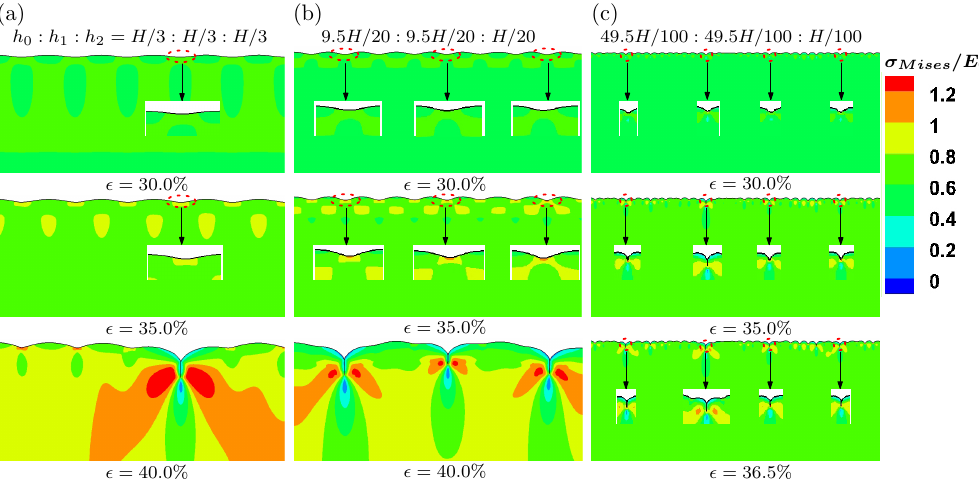
Figure 9. Evolution of surface morphology for a three-layer model at three different levels of compressive strain. ( a ) case I h 0 : h 1 : h 2 = H /3: H /3: H /3; ( b ) case II h 0 : h 1 : h 2 = 9.5 H /20:9.5 H /20: H /20; ( c ) case III h 0 : h 1 : h 2 = 49.5 H /100:49.5 H /100: H